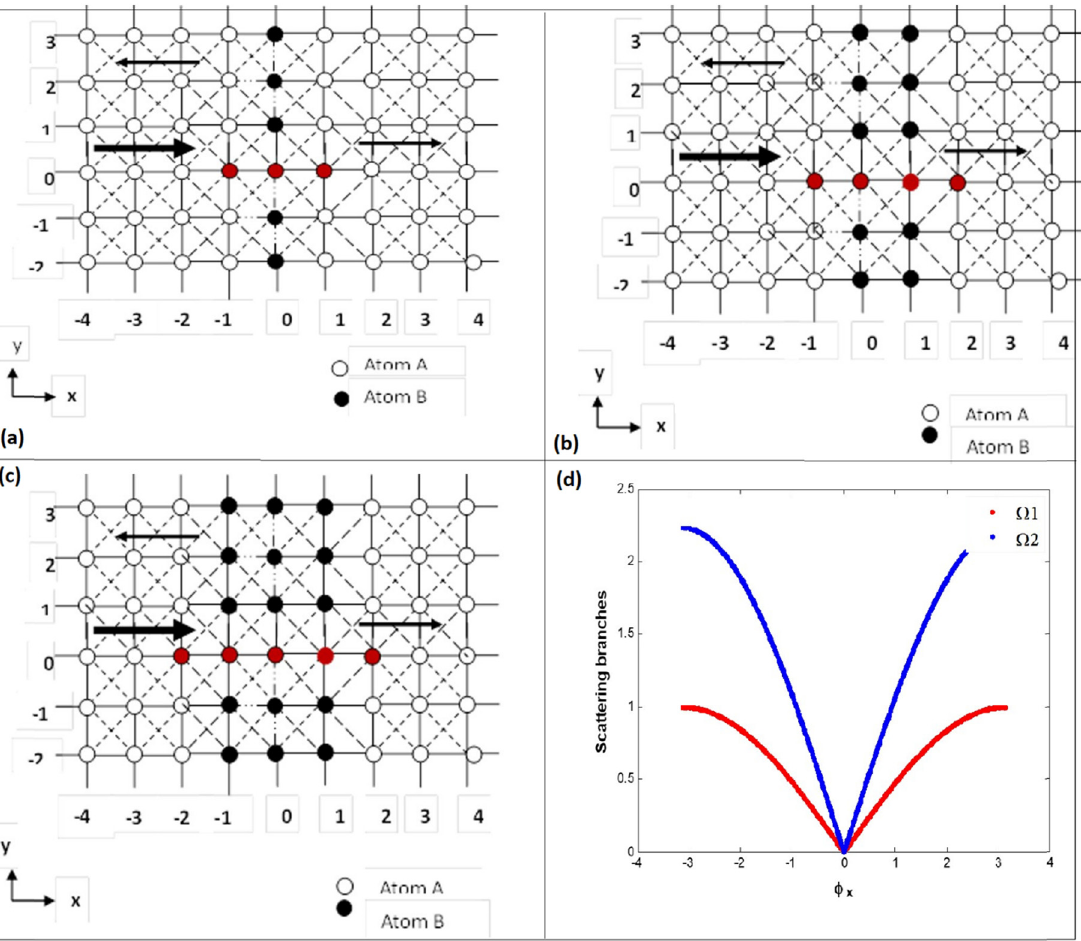
Figure 1: ( a ) System with one integrated chain. ( b ) System model with two integrated chains. ( c ) System model with three integrated chains. ( d ) Dispersion branches of mode 1 and mode 2 as function ϕ r 2 ration of elastic constant of fi rst and second neighbors. x and